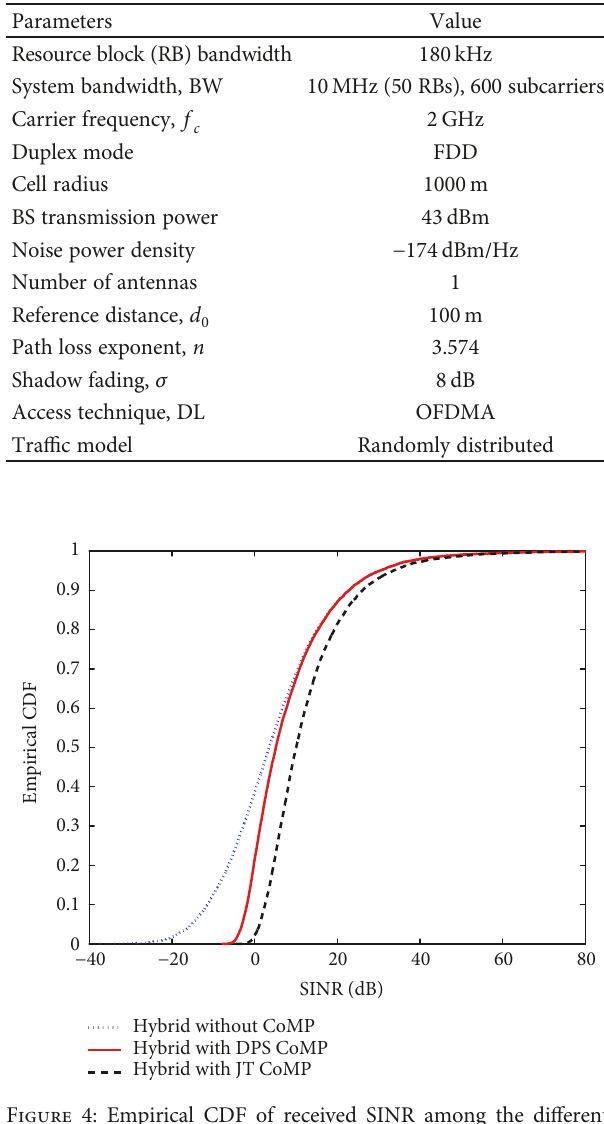
Figure 4: Empirical CDF of received SINR among the di ff erent hybrid systems for x = 1